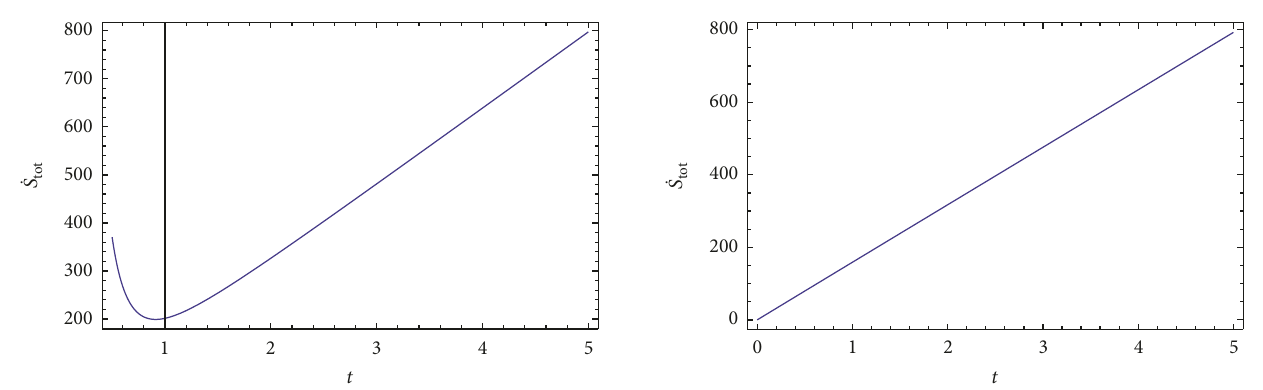
̇𝑆 Figure 13: Plot of tot by taking Renyi entropy as entropy at event horizon.